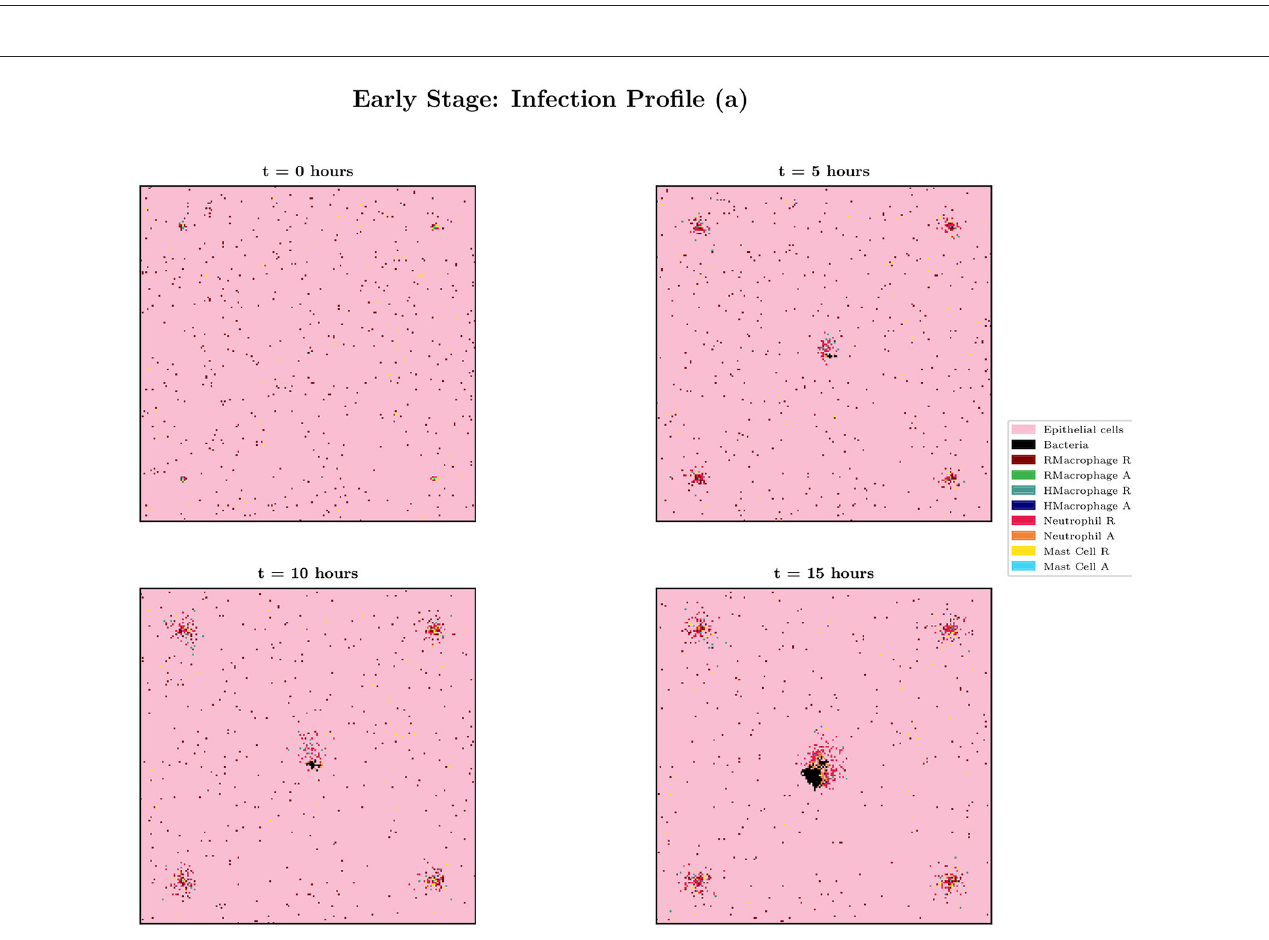
FIGURE7 Spatial plot showing the agents in the system for simulation (a) from Figures 5, 6 at times t = 0,5,10 and 15 h. Agents and blood vessels indicated by the key in the